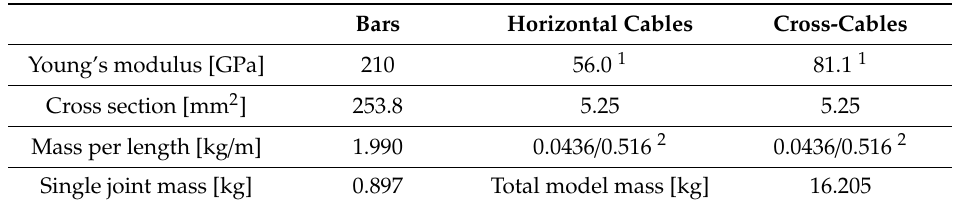
Figure 2. The model of the simplex: ( a ) the view; ( b ) details of the nodes; ( c ) the force transducer. Table 2. Material parameters of the simplex. Bars Horizontal